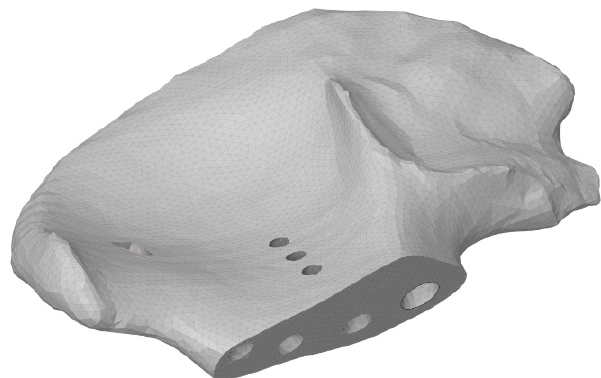
Figure 8. Screw holes in the model of the right pelvic bone.